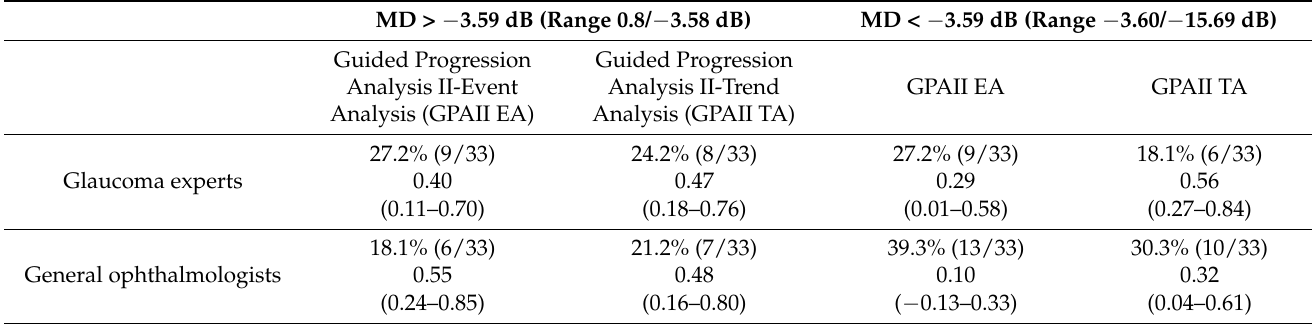
Table 2. Percentage of VF series with discordant opinion and k statistics with 95%CI between GPAII EA and TA and glaucoma experts’ and general ophthalmologists’ evaluation considering VF series with baseline MD greater or less than baseline median MD ( − 3.59 dB).